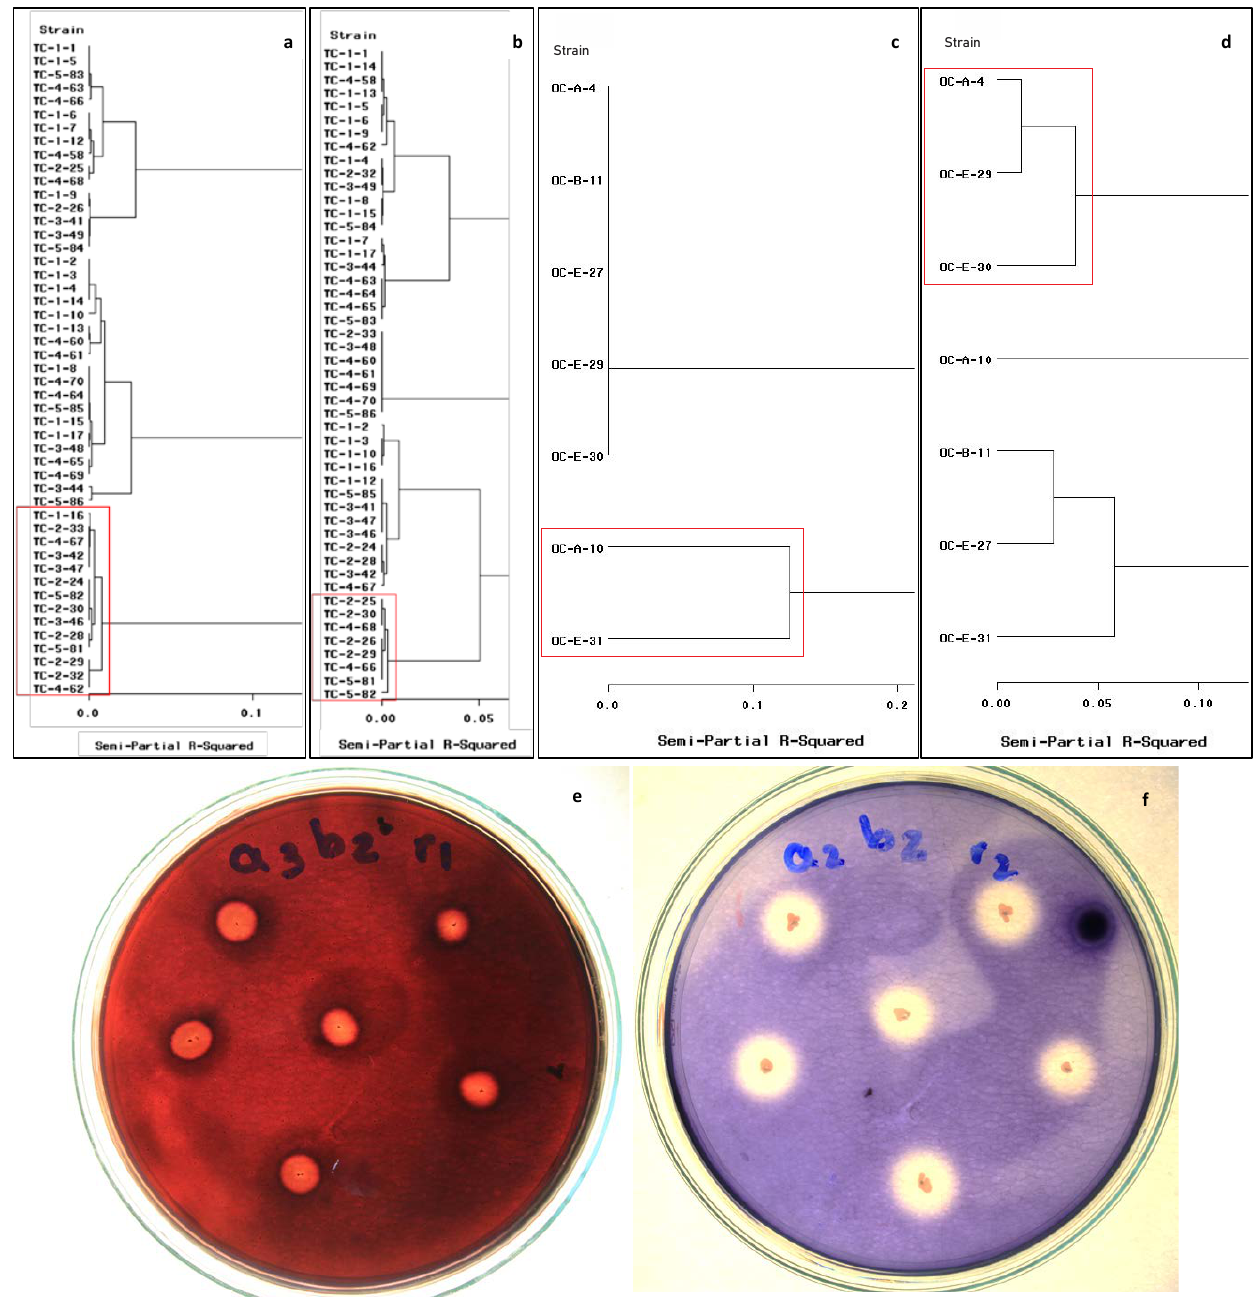
Figure 1. Cluster analysis (Ward’s method) for the bacterial extracellular enzyme activity at 15 °C. Cellulolytic activity ( a ) and amylolytic activity ( b ) from CMCP. Cellulolytic activity ( c ) and amylolytic activity ( d ) from OPF isolates. Strains showing high metabolic activities are a highlight in a red frame. Halos around bacterial colonies are indicative of cellulose degradation ( e ) and amylose degradation ( f ).